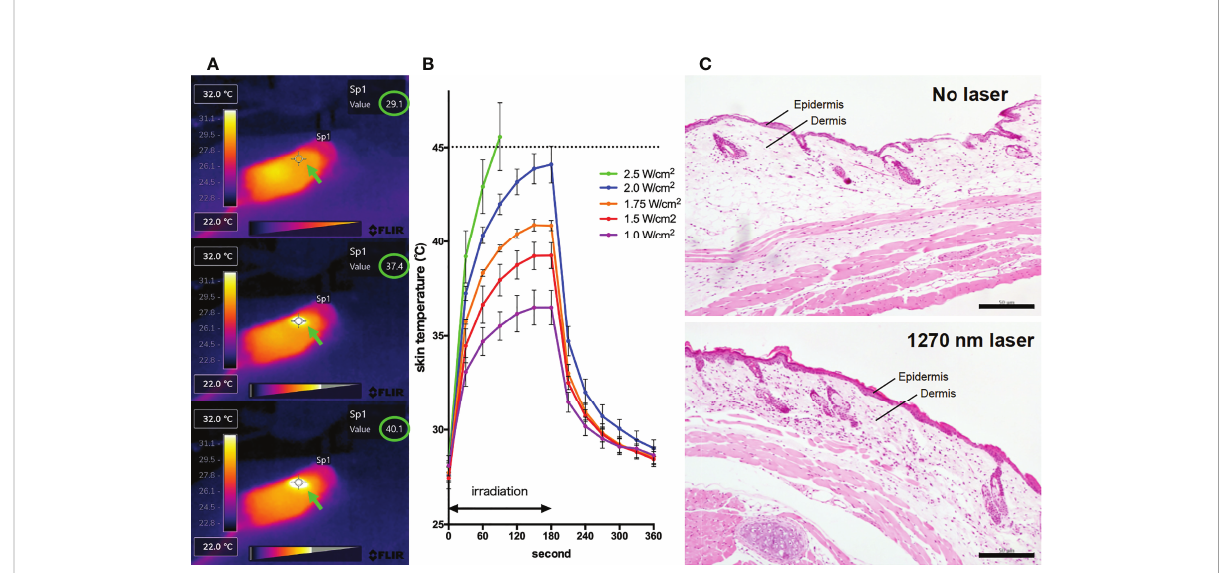
FIGURE 1 Effect of the near-infrared (NIR) 1270 nm laser adjuvant on skin tissue. (A) Representative images for measurement of the mice skin surface temperature using an infrared camera. Irradiated areas (arrows) and detected temperatures (circles) are shown. (B) Dose-temperature responses of the continuous wave 1270 nm laser for 180 s irradiation in mouse skin. Temperature represents the maximal skin surface temperature of irradiated center. Error bars show means ± s.e.m. (C) Microscopic assessment of skin damage and in fl ammatory in fi ltration after laser treatment. Representative images of hematoxylin-eosin-stained skin tissue are presented. In the laser group, epidermis, dermis, and deeper layers were intact. The scale bar represents 50 m